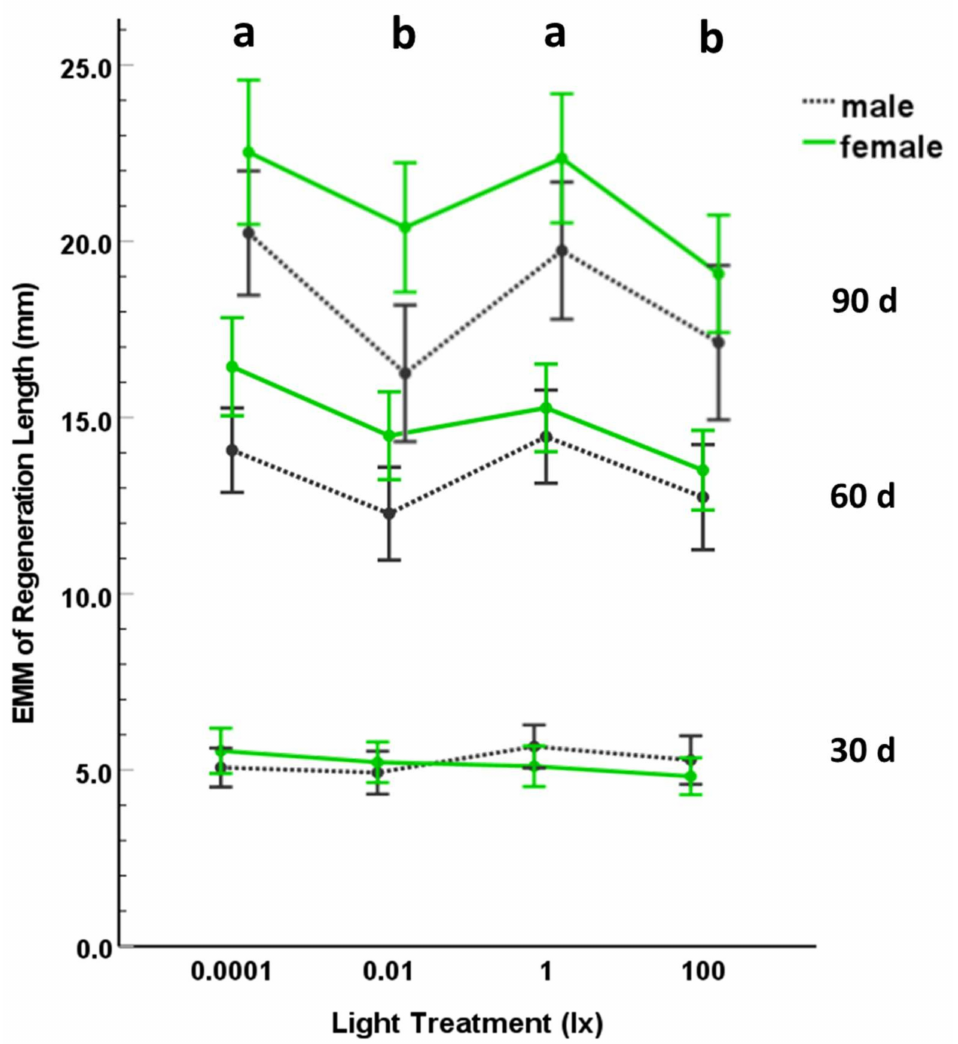
Figure 2. Estimated marginal means (EMM) of regeneration length (mm) for male and female salaman- ders after 30, 60, or 90 d exposure to nocturnal ambient lighting of 0.0001, 0.01, 1, or 100 lx. The error bars represent 95% CI. Different letters represent treatments that were significantly